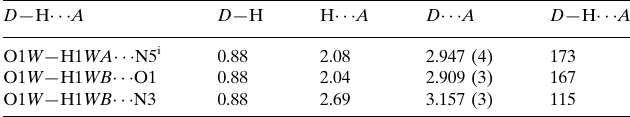
Hydrogen-bond geometry (A˚ , (cid:2)